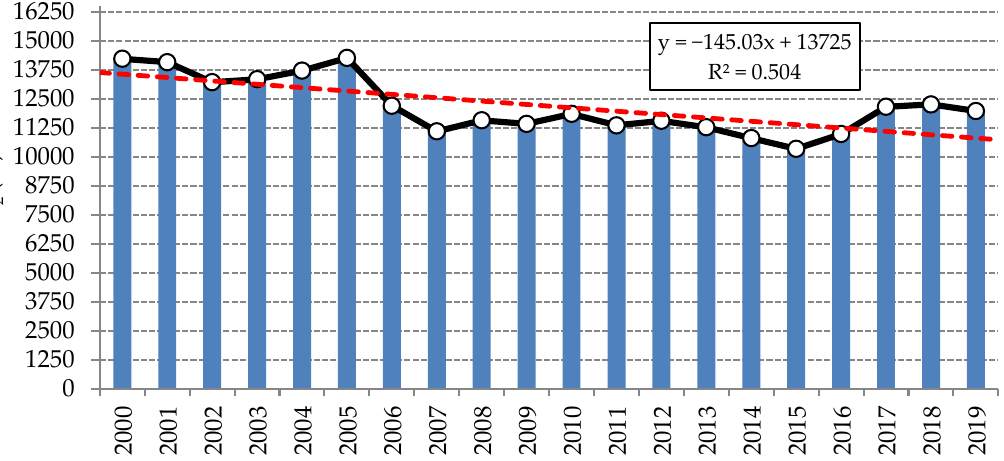
Figure 2. Emissions from energy consumption in Polish agriculture in 2000–2019 (CO 2 equivalent, kt—thousand tons).